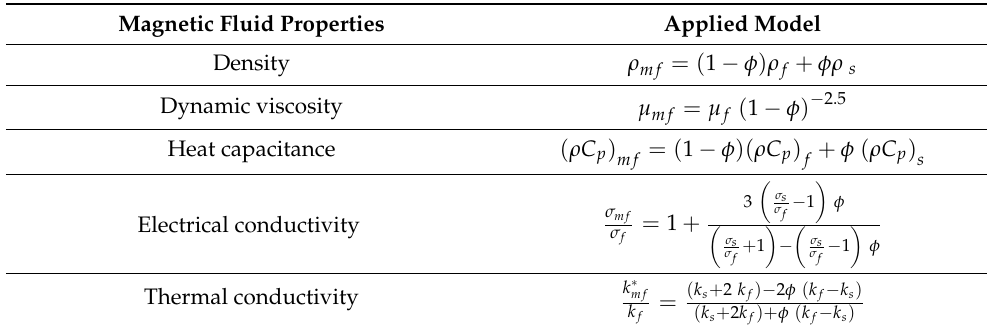
Table 1. Thermophysical properties of magnetic fluid model